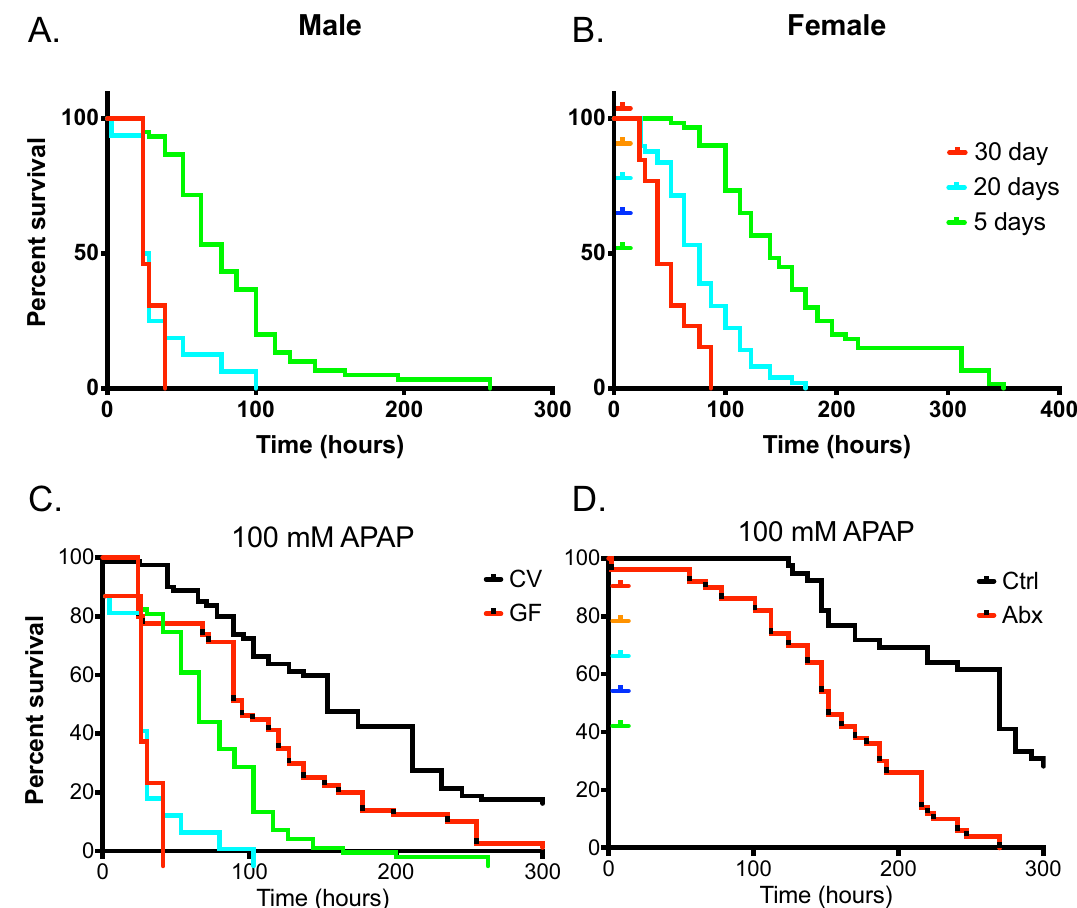
Figure 4. Effects of age and the microbiome on APAP-induced mortality. Susceptibility of 5, 20, and 30-day old ( A ) male and ( B ) female flies to APAP induced mortality. Log-Rank test p < 0.0001, n = 60. ( C ) Survival of germ-free (GF) and conventional (CV) Drosophila exposed to 100 mM APAP. ( D ) Effect of antibiotic-mediated depletion of the microbiome on susceptibility to APAP toxicity. Log-Rank test p < 0.0001, n =